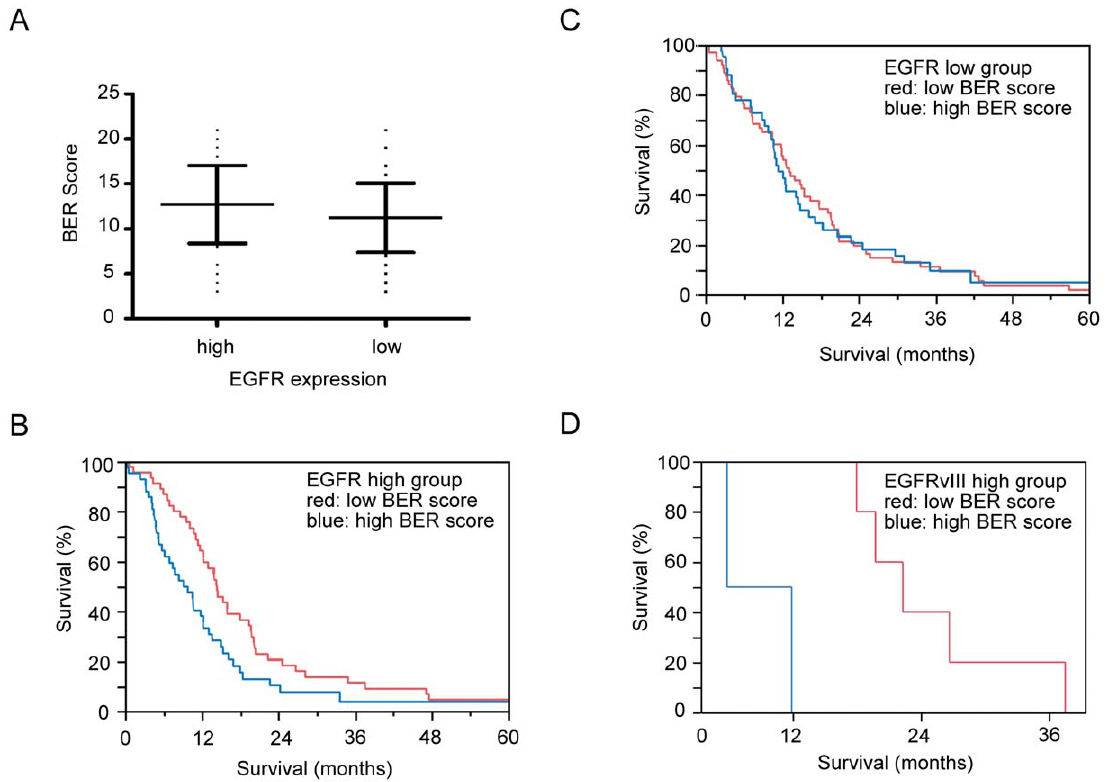
Figure 4. Association between EGFR and BER gene expression and clinical outcome. (A) In clinical specimens, EGFR expression and BER score showed no correlation. (B) Patients with high EGFR expressing glioblastomas with low BER score exhibited improved survival, log rank p=0.01. Red: low BER score; blue: high BER score; median survival times of 14.5 and 9.2 months, respectively. (C) BER gene expression did not impact patients with glioblastomas exhibiting low EGFR expression, log rank p=0.99. (D) Patients with EGFRvIII expressing glioblastomas with low BER score exhibited improved survival, log rank p=0.008. Red: low BER score; blue: high BER score; median survival times of 22.6 and 8.9 months, respectively.